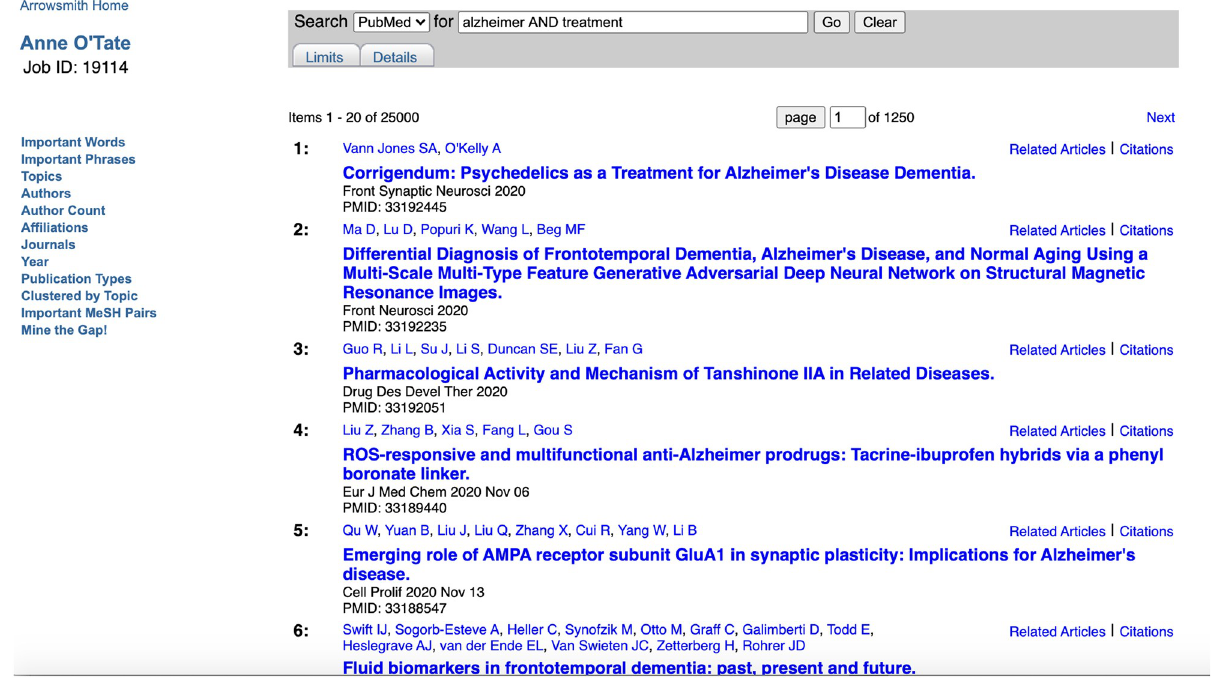
Fig 2. Screenshot of the list of articles retrieved from PubMed using the query [Alzheimer AND